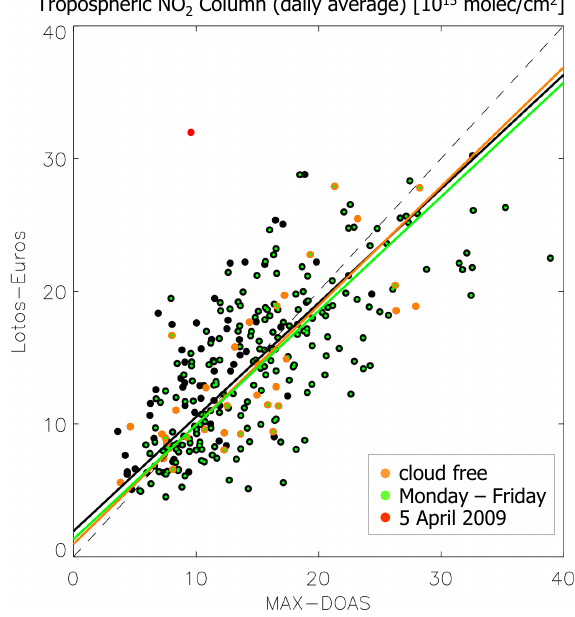
Tropospheric NO Column (daily average) [10 15 molec/cm 2 ] 2